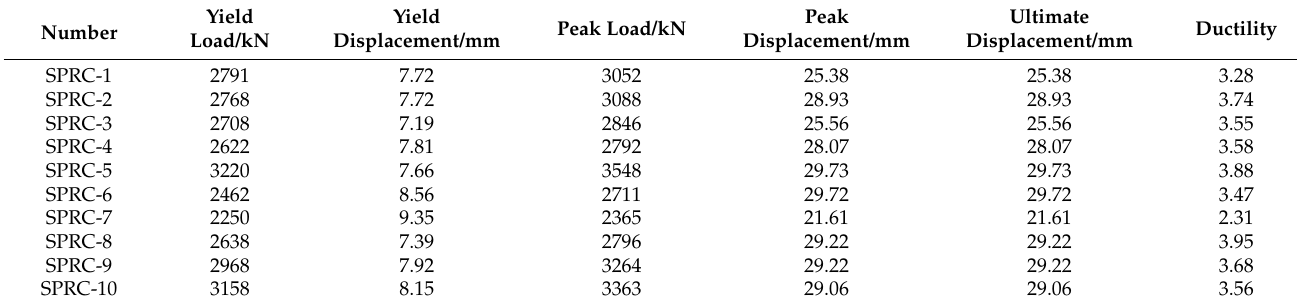
Table 4. Results for